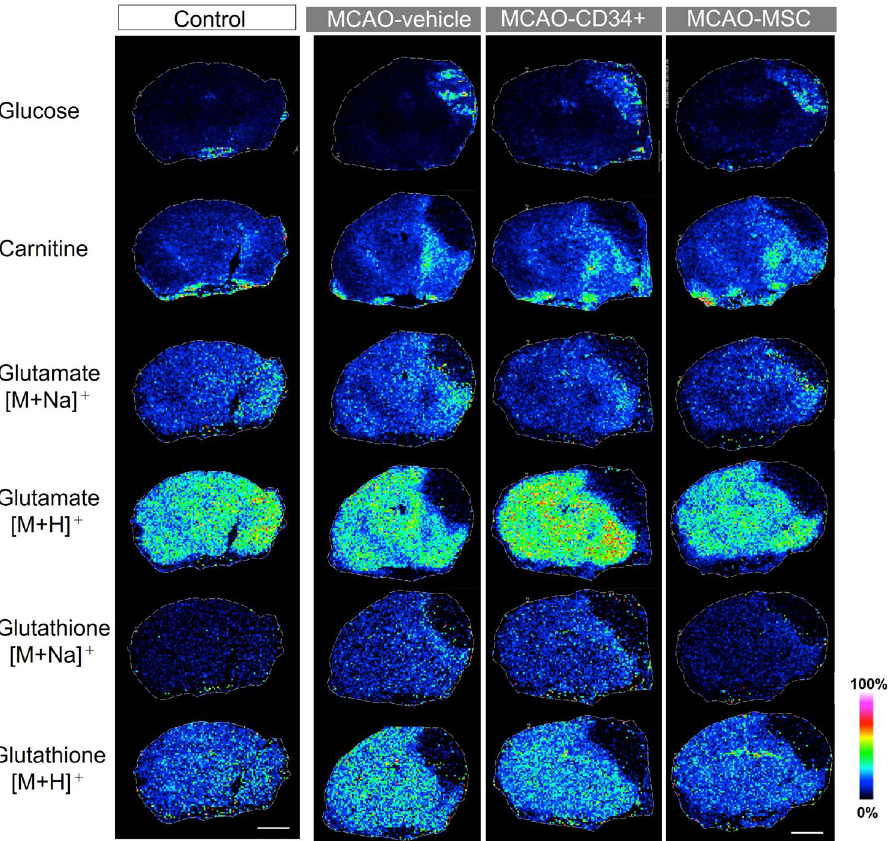
Figure 6. Mass spectrometry imaging. MS imaging was used to visualize the spatial changes and distributions of metabolites in the brains of mice that underwent MCAO. Metabolites were simultaneously visualized in a single scan, and the displayed brain images in each group were from a single mouse. Scale bars are 2.0